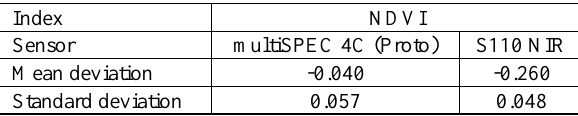
Table 3. Comparison of multispectral sensors with field spectrometer measurements based on derived NDVI